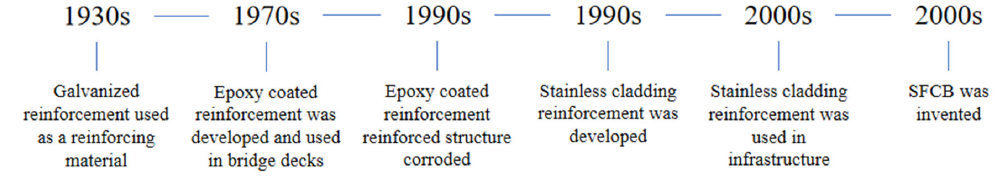
Figure 3. The development of anti ‐ corrosion reinforcements using coating technologies